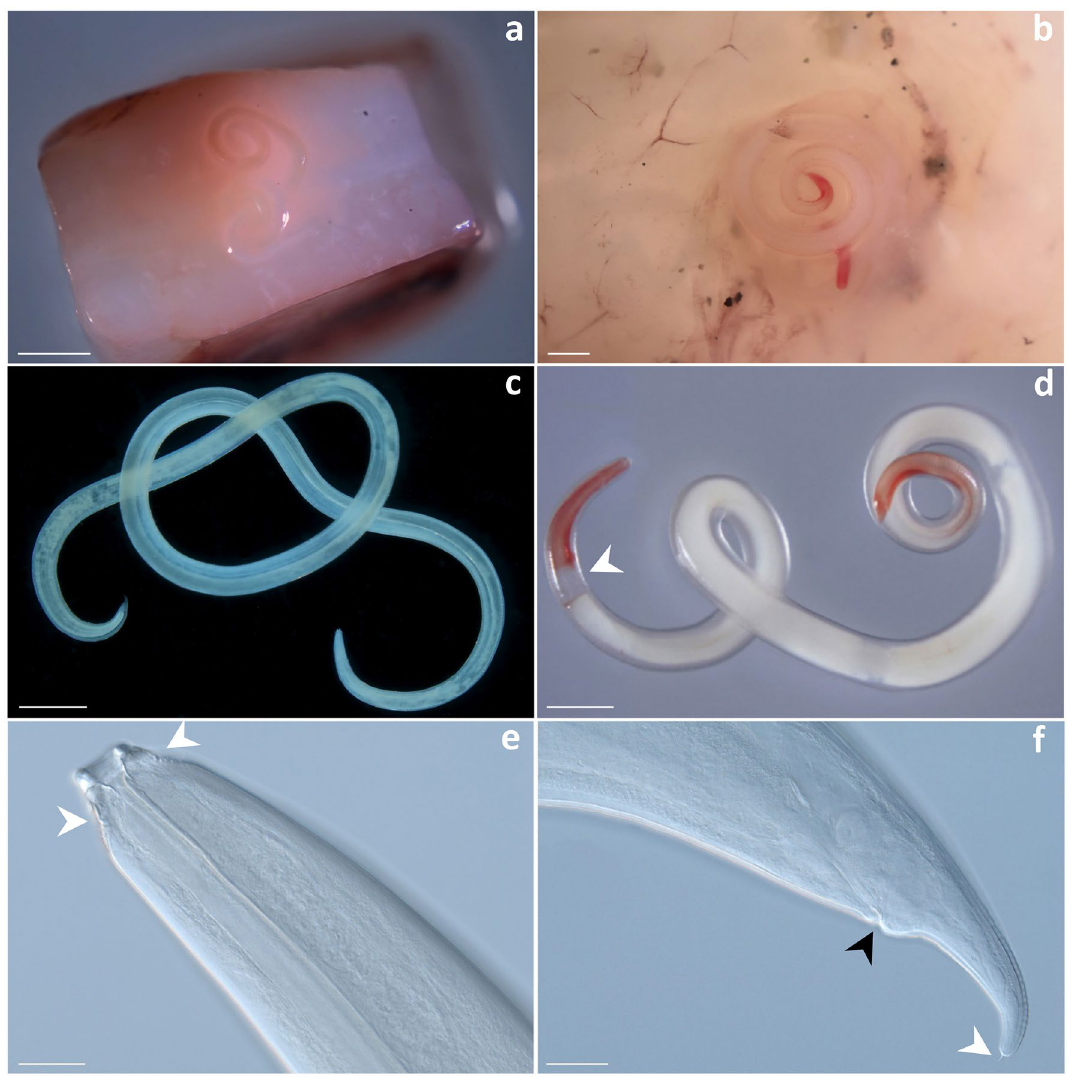
Figure 1. Lappetascaris sp. and Anisakis physeteris in Histioteuthis squids collected from the Tyrrhenian Sea. Lappetascaris larva in the mantle musculature of an umbrella squid ( a ). Anisakis physeteris in the testis of an umbrella squid. Note the worm extremities reddish in colour ( b ). Microscopic view of Lappetascaris sp. larva ( c ) and A. physeteris showing the extremities reddish in colour and ventriculus (arrow) ( d ). Cephalic extremity of Lappetascaris sp. larva showing sclerotized formations (arrows) ( e ). Caudal extremity of Lappetascaris sp. larva showing anus (black arrow) and cuticular spike (white arrow) ( f ). Scale bar: 2000 µm ( a ); 1000 µm ( b , c , d ); 50 µm ( e , f